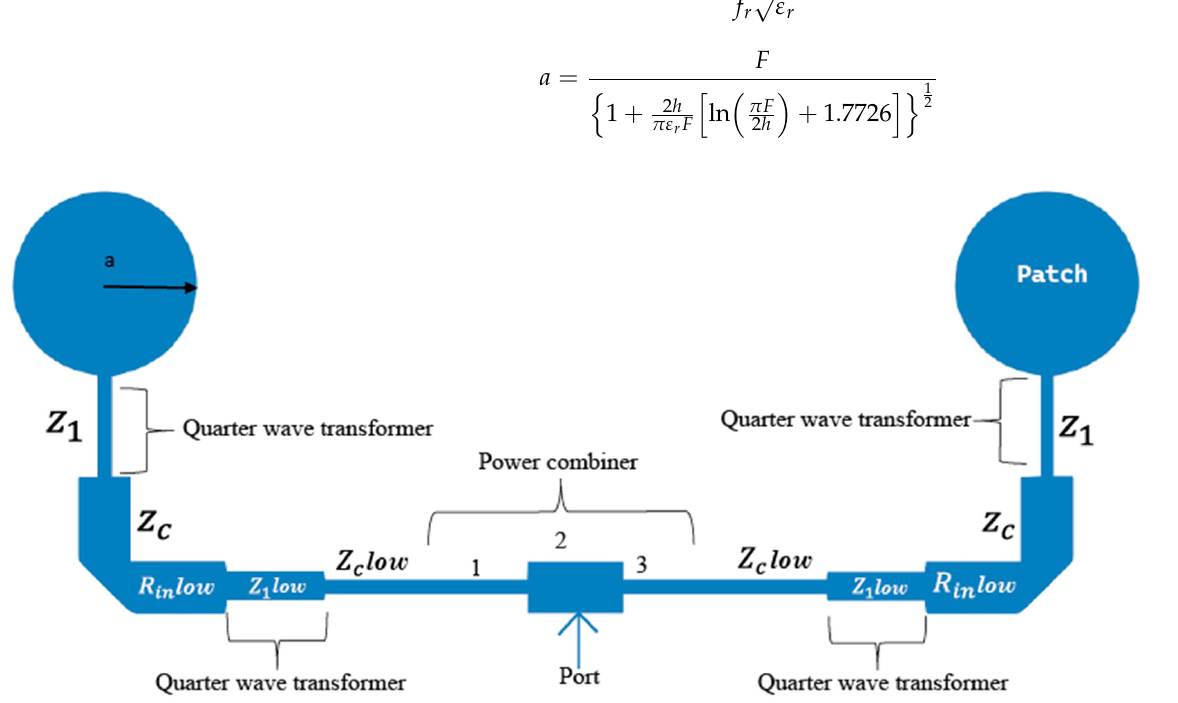
Figure 7. 1 × 2 array of circular patch antenna with quarter-wave coupling. In Figure 7, the dimensions of transmission lines, quarter-wave transformer, and power combiner are the same as those for Antenna